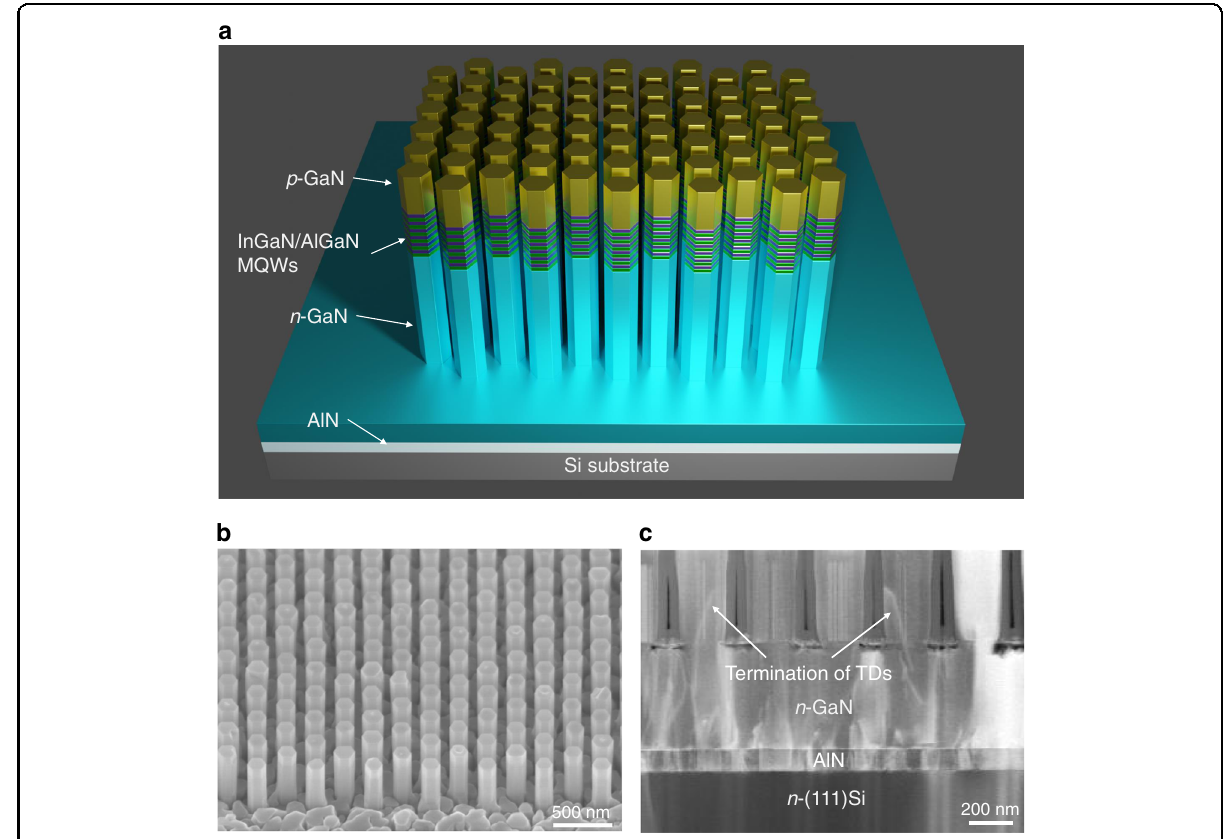
Fig. 1 Schematic illustration of SAE nanowires on Si substrate and the fi ltering effect of nanowires on substrate dislocations. a Schematic of InGaN/AlGaN MQWs-in-nanowire heterostructure grown on Si substrate. b Bird ’ s view SEM image of the as-grown InGaN/AlGaN p-i-n nanowire arrays. c Cross-sectional STEM image of the nanowire on Si substrate showing the termination of TDs on the sidewall of n -GaN nanowire before reaching the active